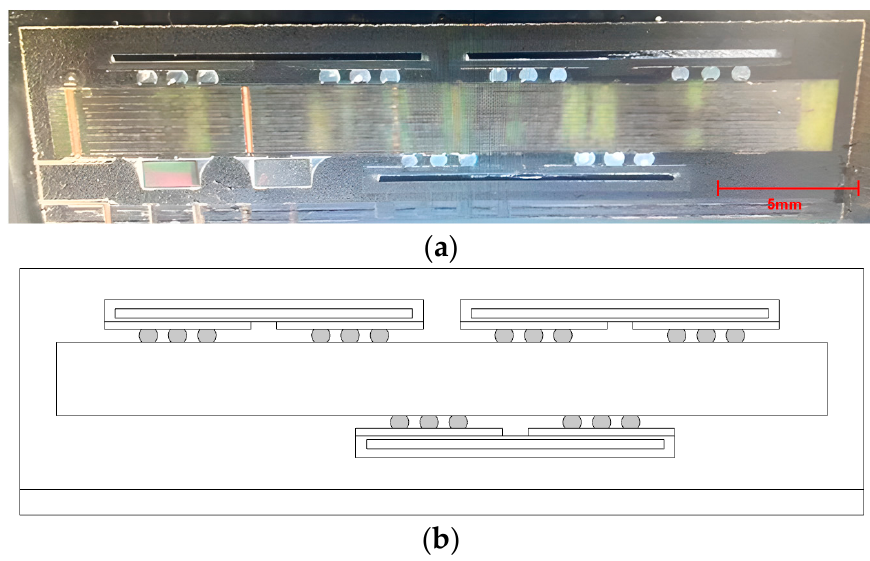
Figure 3. 3D packaging memory device under thermal shock. ( a ) Its cross-section observed by the metallographic microscope; ( b ) its finite element model.